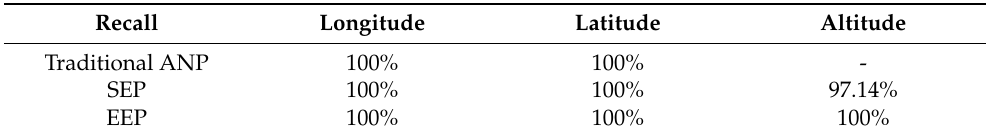
Table 6. Precision comparison of actual navigation performance evaluation algorithm results in Monte Carlo simulation.